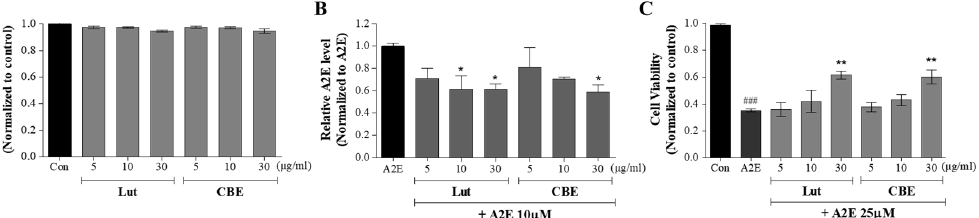
Figure 2. Inhibitory effects of CBE on A2E accumulation and A2E-induced cell death in ARPE-19 cells. ( A ) Nontoxicity of CBE to ARPE-19 cells. ( B ) Suppression of A2E accumulation in ARPE-19 cells by CBE. ( C ) Suppression of A2E-induced ARPE-19 cell death by CBE. The values represent the mean ± SD ( n ≥ 3). ### p < 0.001 vs. control group; * p < 0.05, ** p < 0.01 vs. A2E group, one-way ANOVA with Tukey’s post hoc test.